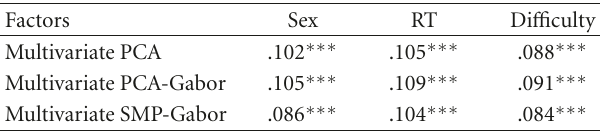
) values from a repeated-measures Table 2: Partial eta-squared ( η 2 p general linear model (GLM) for the three methods for ERP analysis. Multivariate tests indicate statistical values across all